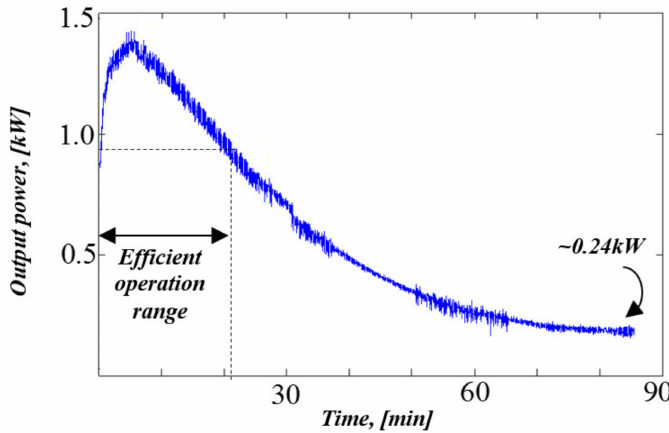
Figure 4. Measured APU output power versus time during depleted lead-acid battery charging.